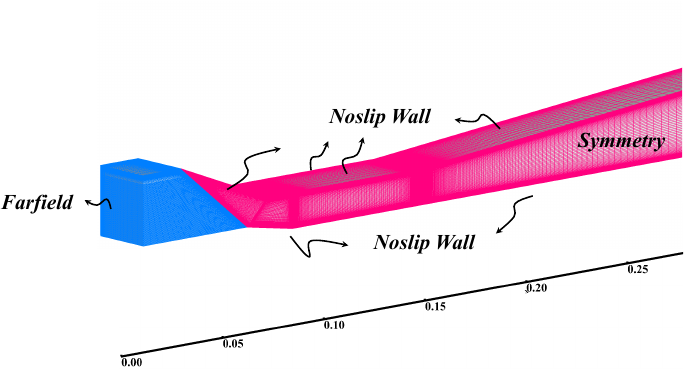
Figure 5. Mesh of the 3D computational domain.